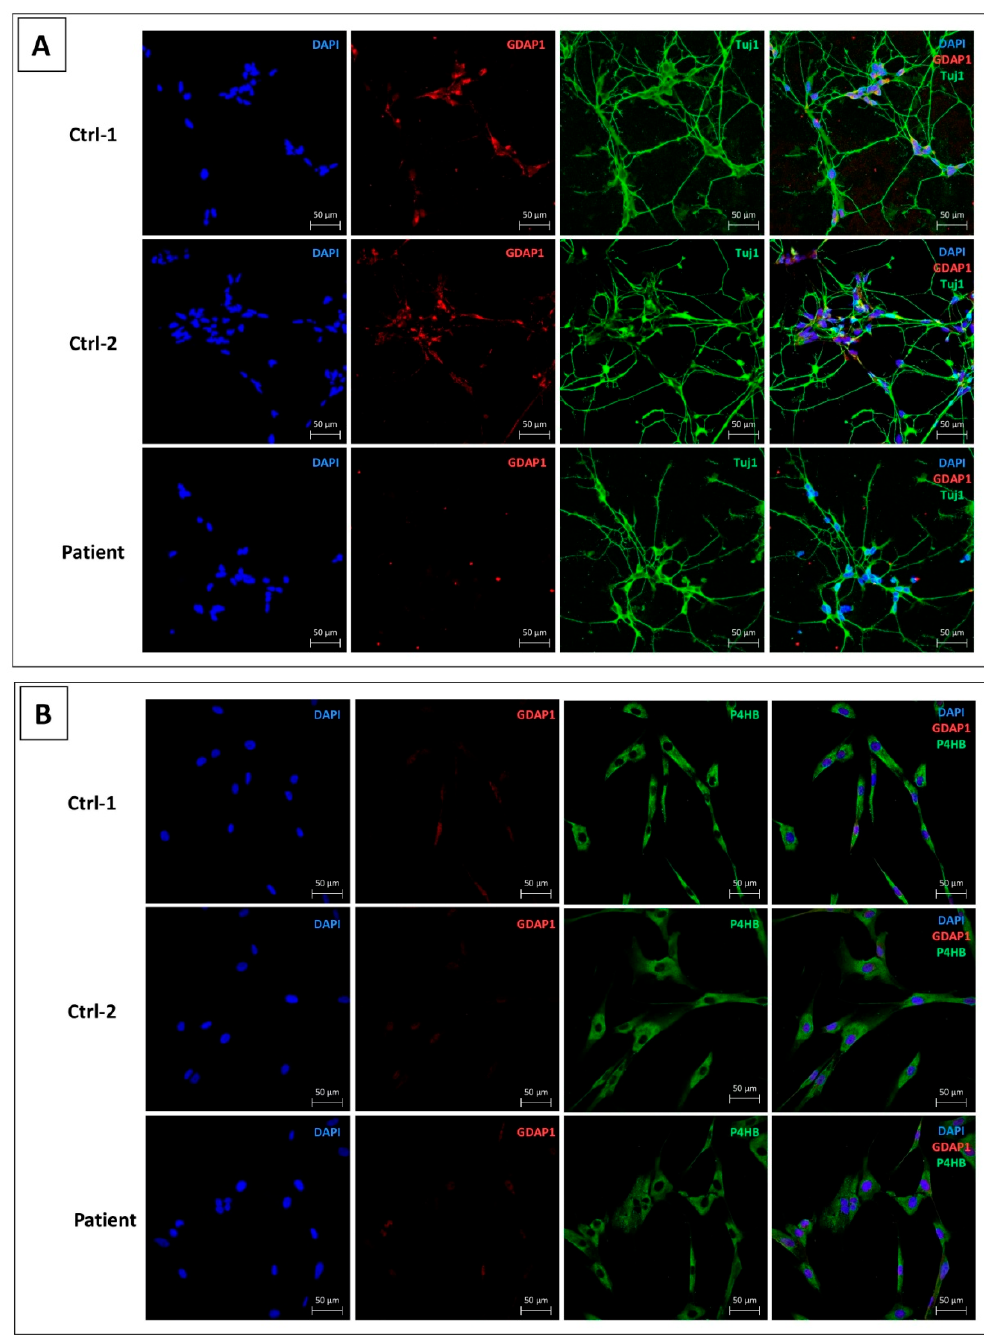
Figure 4. GDAP1 protein expression in MNs ( A ) and fibroblasts ( B ). ( A ) DAPI (blue) for nuclei staining, GDAP1 (red), and β -tubulin III (green), as neural marker. ( B ) DAPI (blue) for nuclei staining, GDAP1 (red), and prolyl 4-hydroxylase subunit- β antibody (P4HB) (green), as fibroblast marker. Scale bar = 50µm.